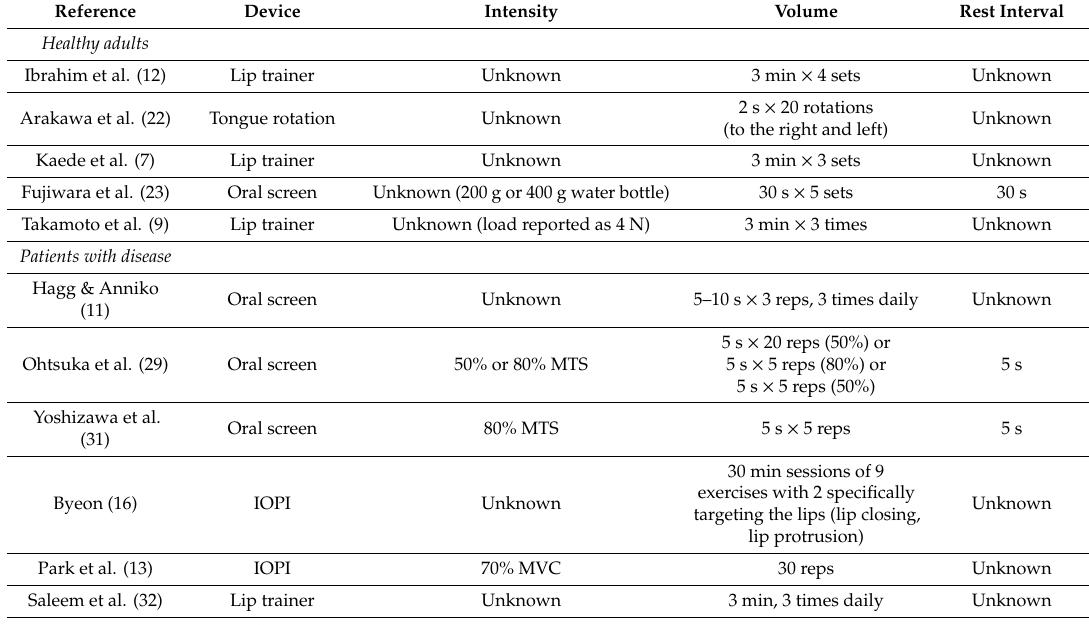
Table 3. Training program including exercise intensity, volume, and rest interval between sets of lip strength